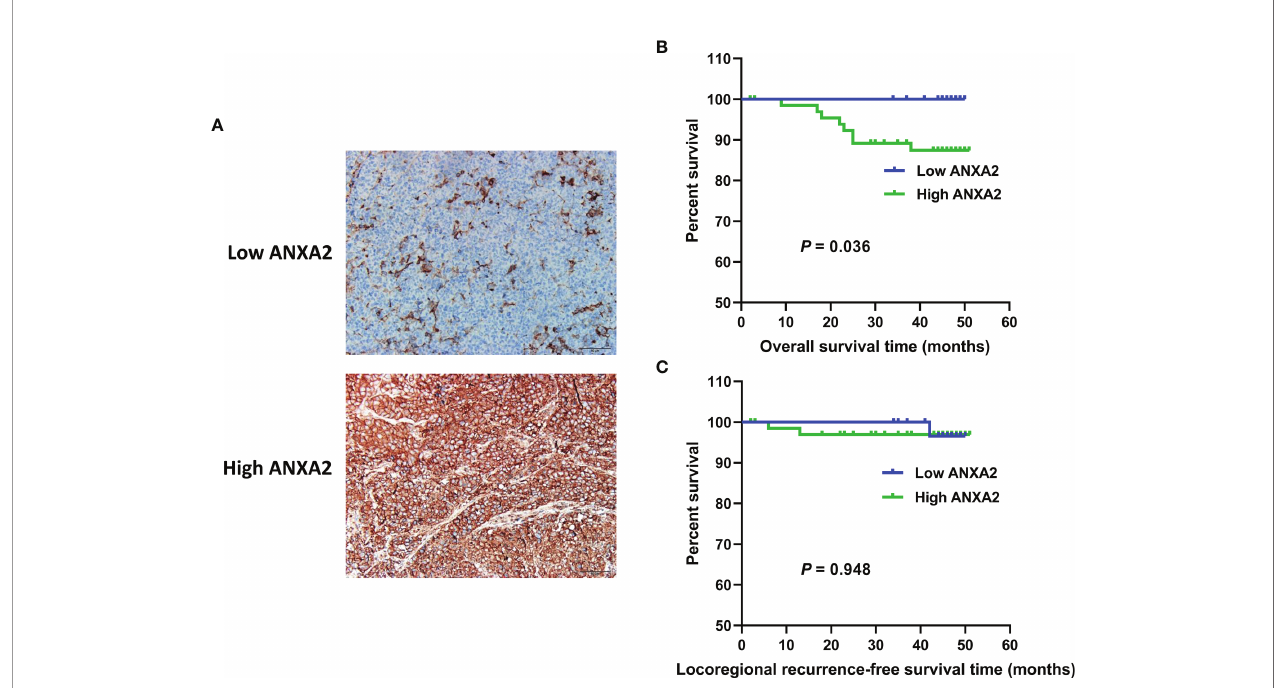
FIGURE 1 | ANXA2 expression in NPC specimens and its association with overall survival and Locoregional recurrence-free survival in NPC patients. (A) immunohistochemical analysis of ANXA2 expression in NPC specimens, scale bar = 50 m m; (B, C) Kaplan-Meier survival curves of NPC patients with high ( n = 67) and low ( n = 33) ANXA2 expression, and the comparison of overall survival (B) and Locoregional recurrence-free survival (C) were done using a log-rank